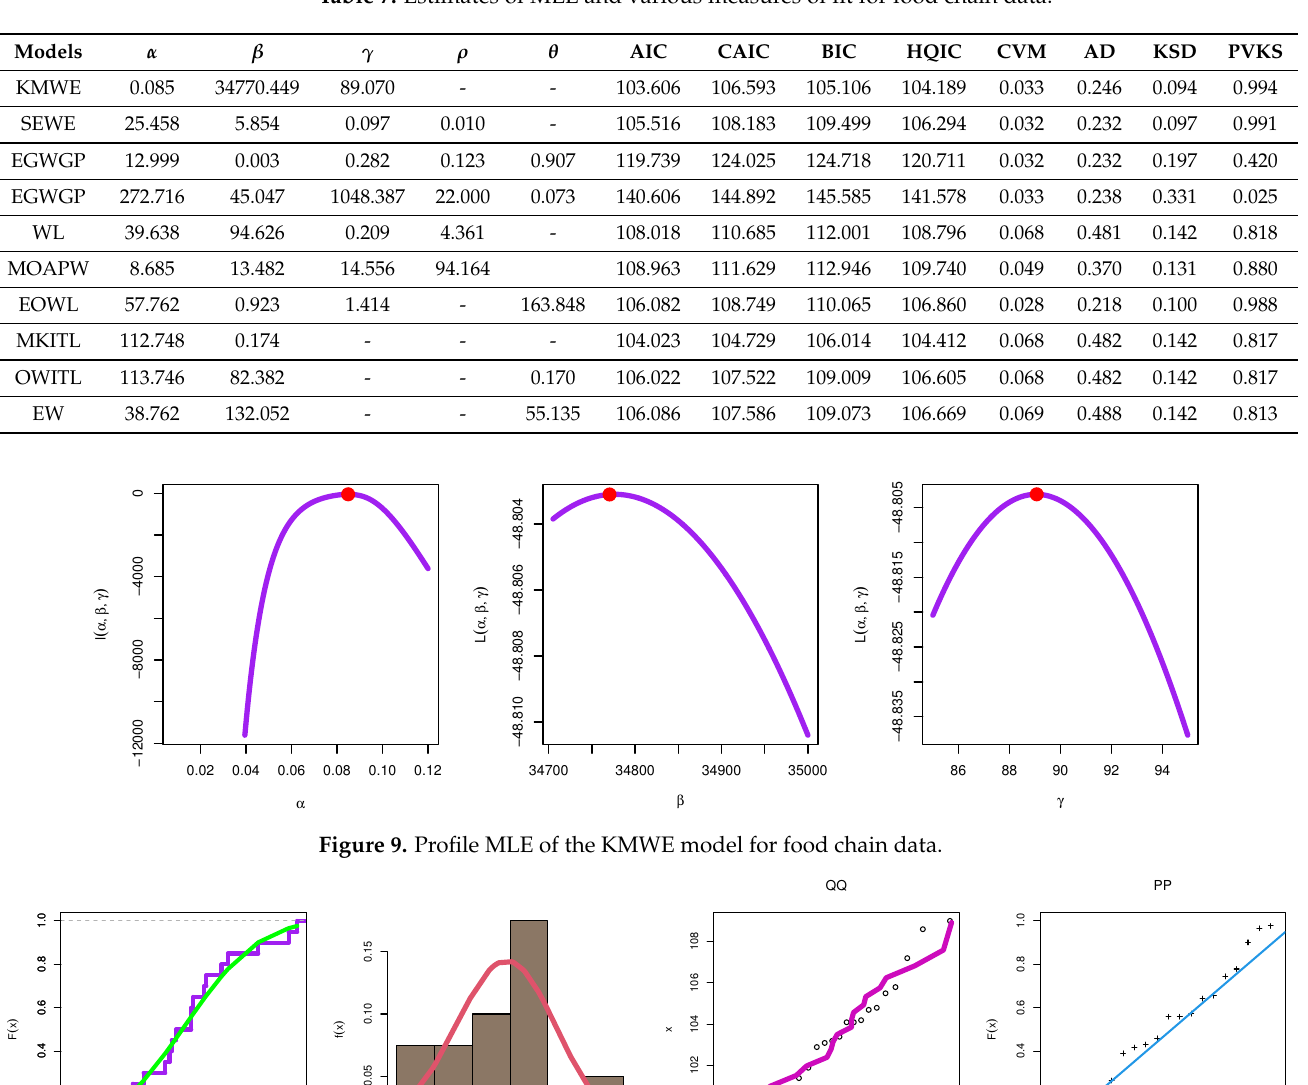
Table 7. Estimates of MLE and various measures of fit for food chain data.